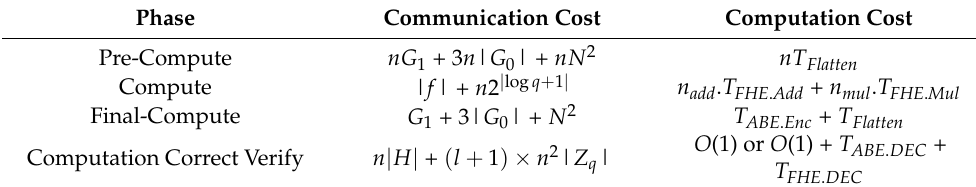
Table 6. Communication and computation cost(s) of IoT data